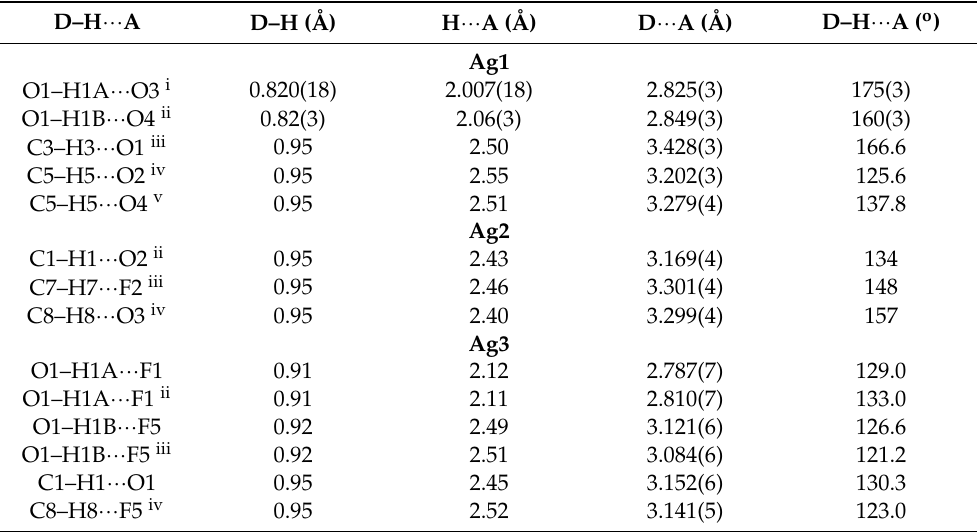
Table 2. Hydrogen-bonding interactions in complexes Ag1 – 3 .